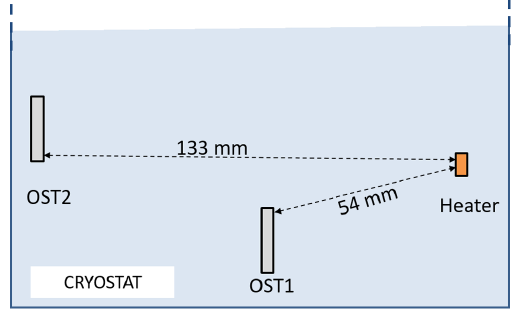
11. Picture of the experimental setup.